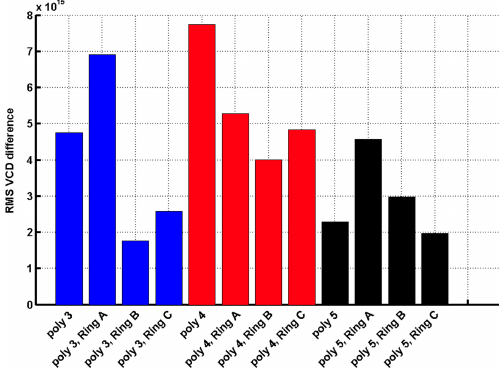
Fig. 12. Root mean square of HCHO VCD differences (moleccm − 2 ) obtained using two alternative methods for the cal- culation of vertical columns (see text and Fig. 9). Various choices of retrieval settings are tested using polynomials of degree 3 (blue), 4 (red) and 5 (black), respectively, and different Ring effect cross sections. Optimal stability (corresponding to smallest HCHO VCD differences and larger coherence between the results with different Ring choices) is obtained for cases using a polynomial of degree